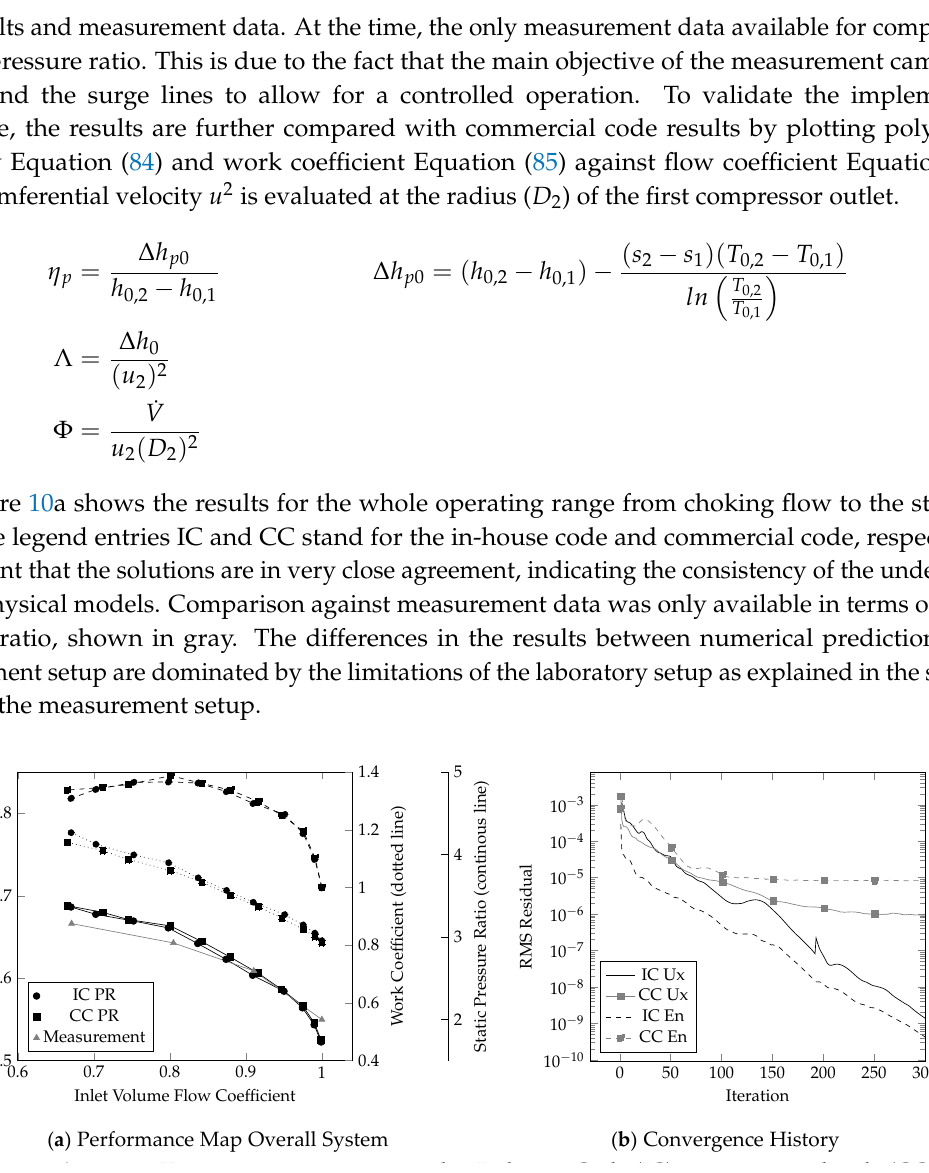
Figure 10. Two-stage compressor results. In-house Code (IC) vs commercial code (CC)